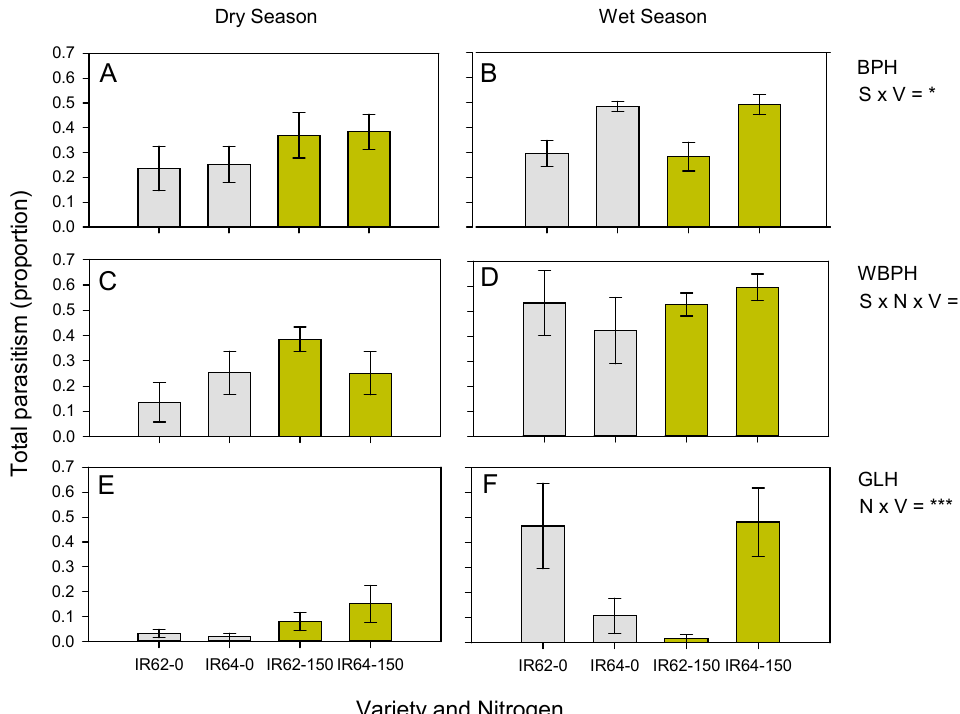
Figure 2. Effects of nitrogen (0 or 150 kg ha − 1 of nitrogen) and variety (IR62: resistant and IR64: susceptible) on percentage parasitism of BPH ( A , B ), WBPH ( C , D ) and GLH ( E , F ) eggs in rice field plots. Experiments were conducted during the dry ( A , C , E ) and wet ( B , D , F ) seasons of 2013. Standard errors are indicated (N = 6); results of GLM are indicated as ns = p > 0.05, * = p ≤ 0.05 and *** = p ≤ 0.001. BPH = brown planthopper, WBPH = whitebacked planthopper, and GLH = green leafhopper; S = season, N = nitrogen and V = variety.